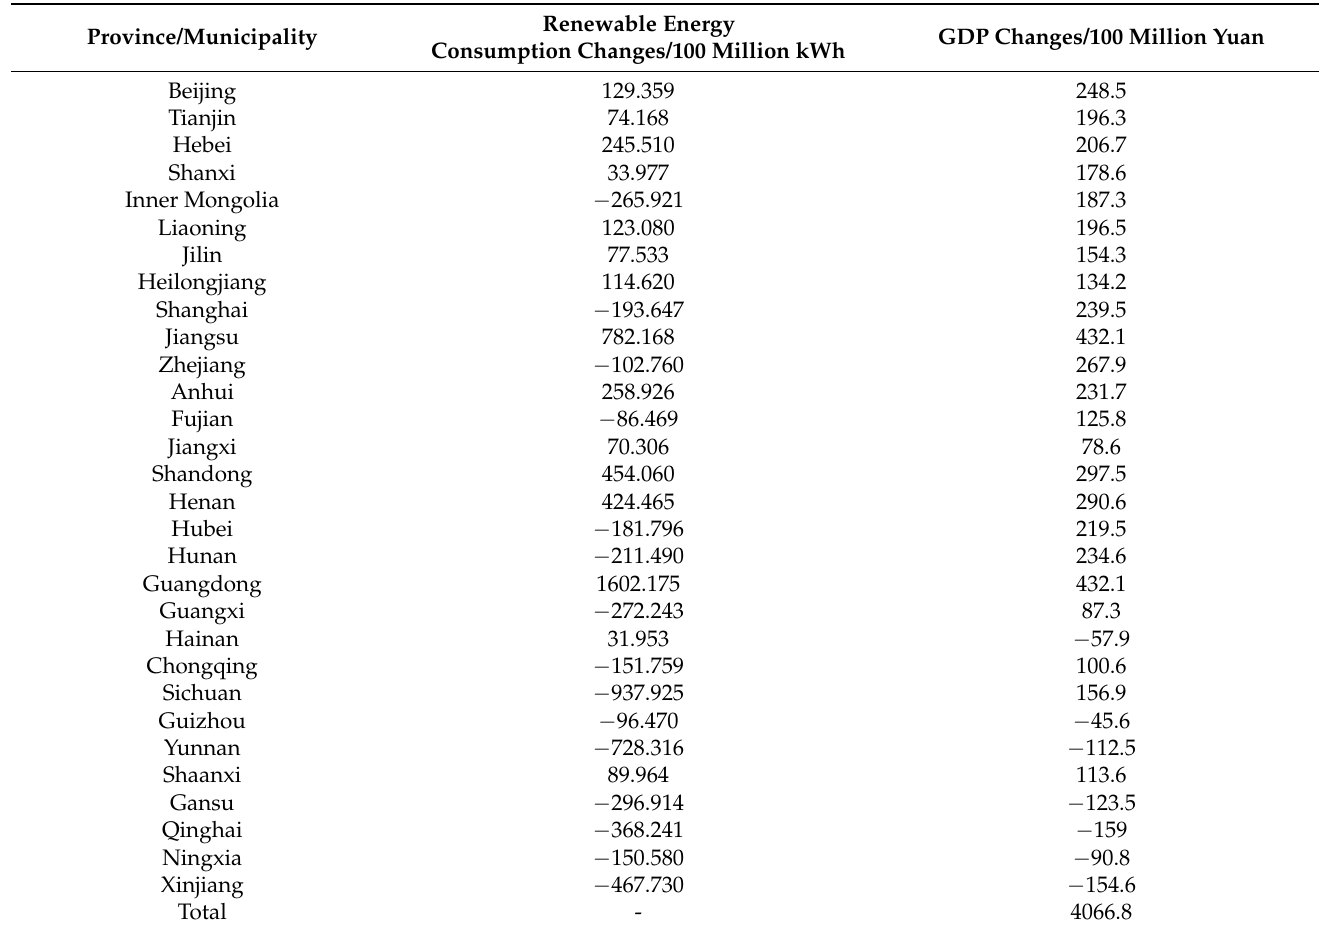
Table 6. Impact of RPS Allocation Efficiency Change on